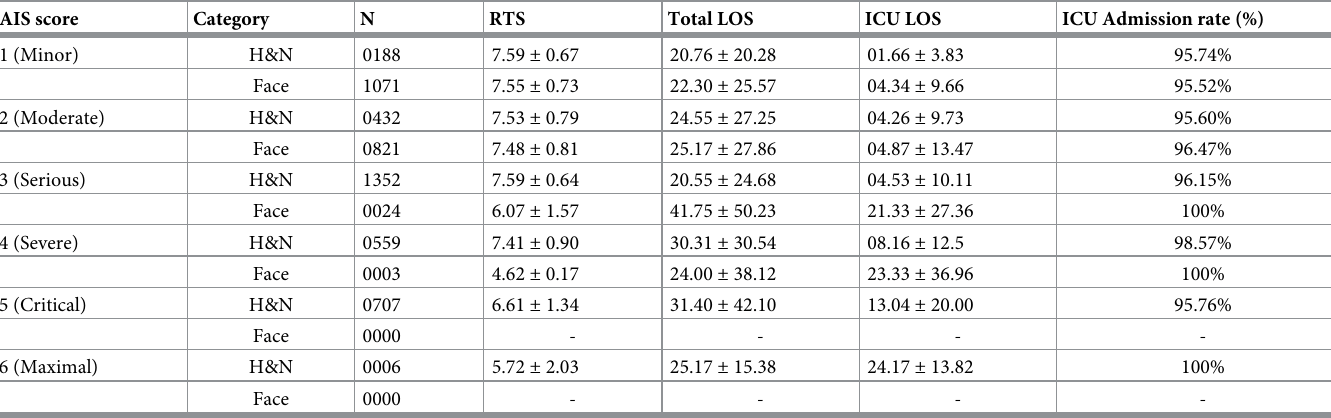
Table 6. Analysis between AIS and